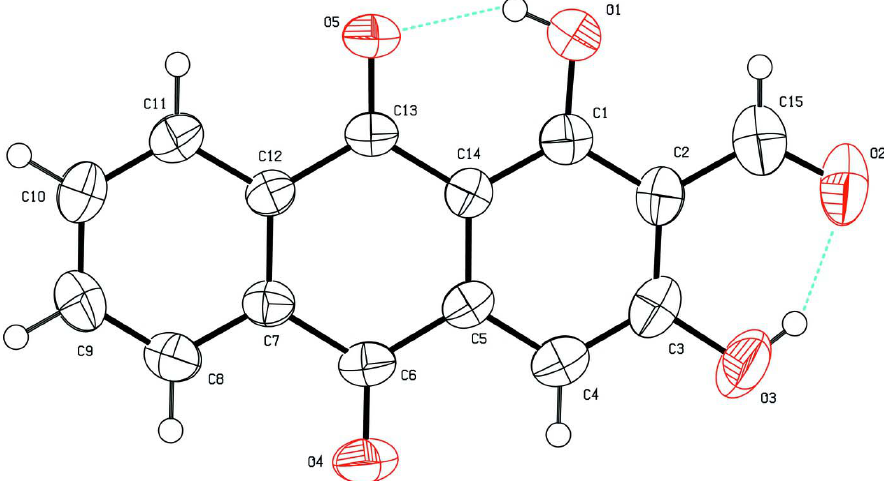
Perspective view of the title compound with the atom numbering; displacement ellipsoids are at the 50% probability level. The intramolecular O—H···O interactions are shown as dotted